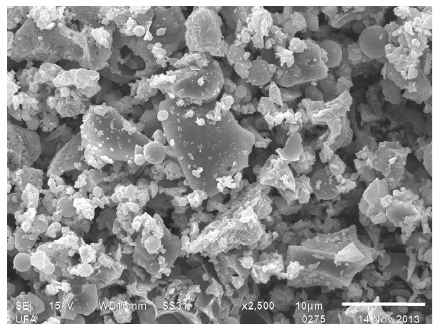
Figure 2: Micromorphology of ground fly ash.